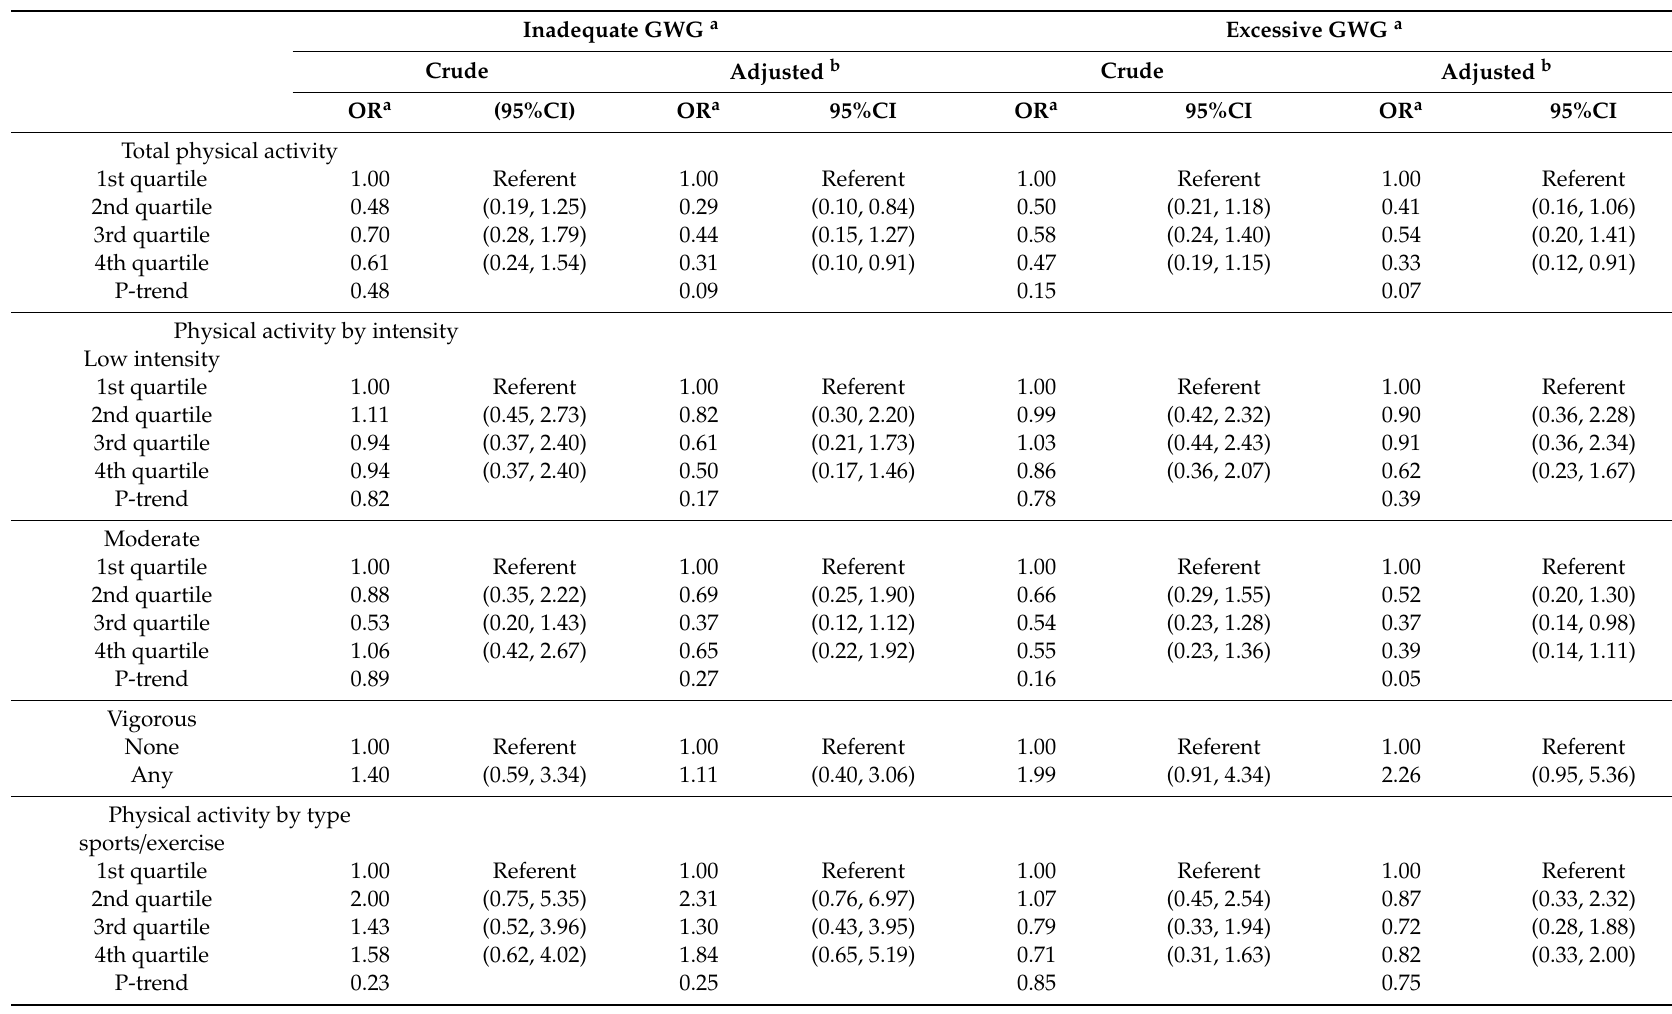
Table 4. The association between third trimester physical activity and gestational weight gain (GWG)